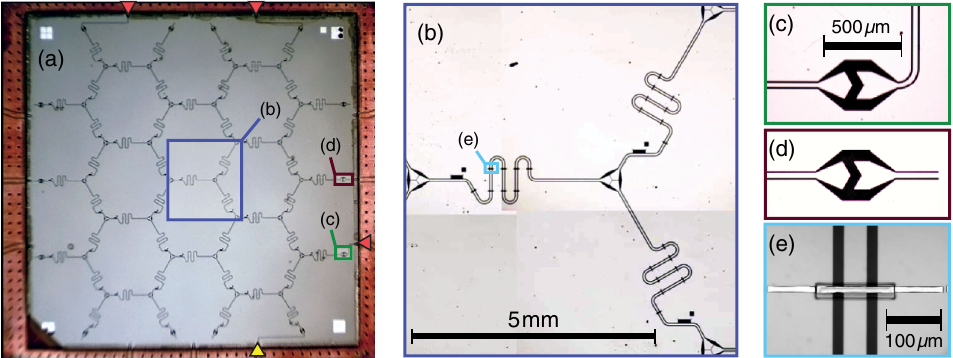
FIG. 3. Device picture of photon lattice, consisting of 49 coupled coplanar-waveguide resonators. (a) The resonators are arranged to form a kagome lattice for photons (the dual of the honeycomb geometry visible when viewing the physical resonators). The device is equipped with a port used to drive the lattice with a coherent microwave tone (yellow triangle), and three possible ports to detect the transmitted signal (red triangles). (b) Resonators have a meandering section (to save space on the chip) and are coupled by three-way capacitors. Small capacitors (c) connect four of the edge resonators to ports and (d) terminate the remaining edge resonators by coupling to a high-frequency resonator stub. (e) Isolated ground planes within the lattice are connected with aluminum bridges evaporated on top of insulating